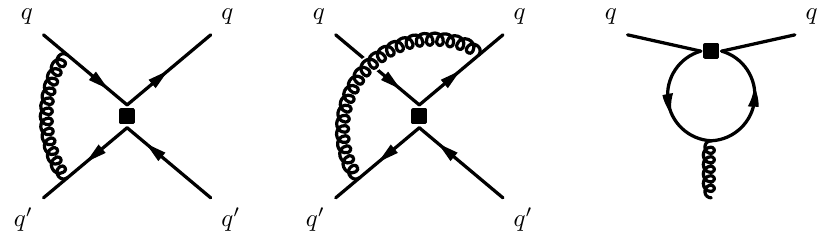
Figure 3 . Selection of diagrams entering the computation of QCD one-loop anomalous dimension of four-fermion operators. The poles of QCD penguin diagrams a(cid:11)ect the mixing via the e.o.m.- vanishing operators de(cid:12)ned in appendix